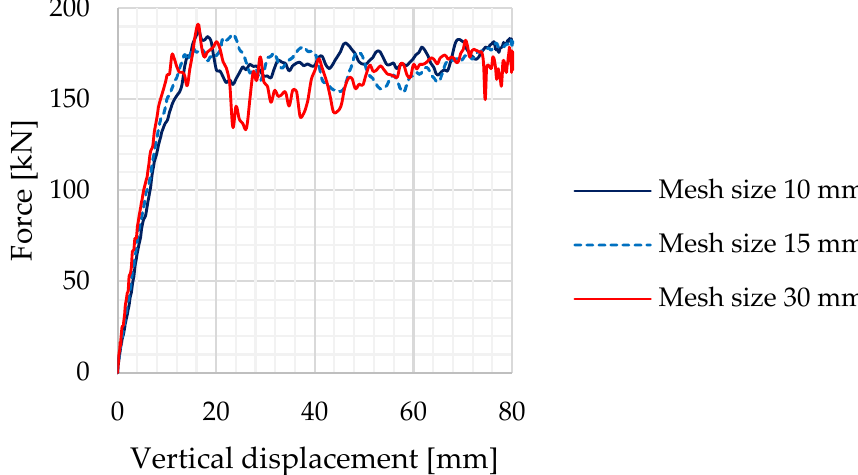
Figure 11. Comparison of force–displacement curves for different mesh sizes.